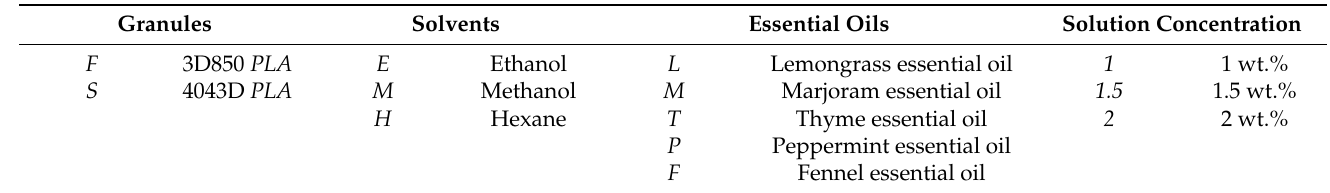
Table 1. Notation for the